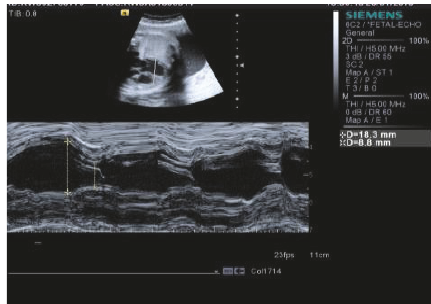
Figure 3: Complete heart block.